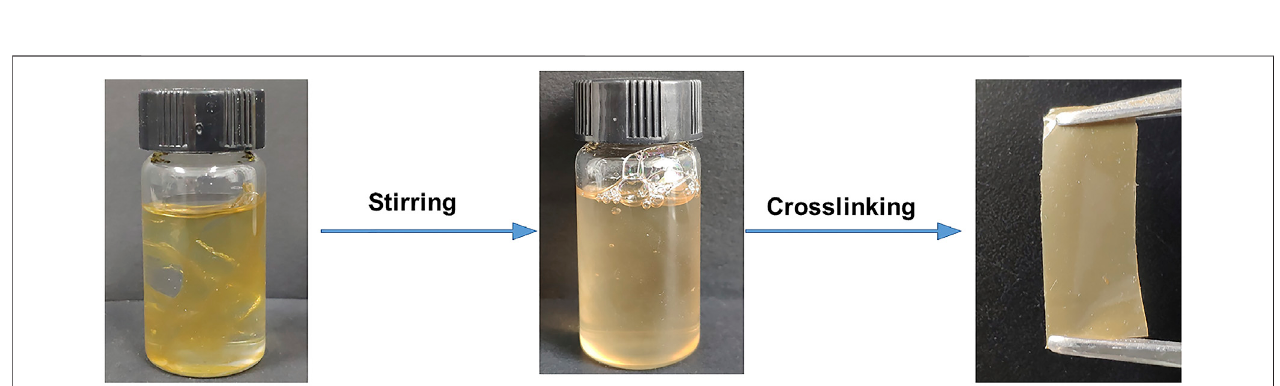
FIGURE 7 | The reversible fi lm formation by hydrogen bonding